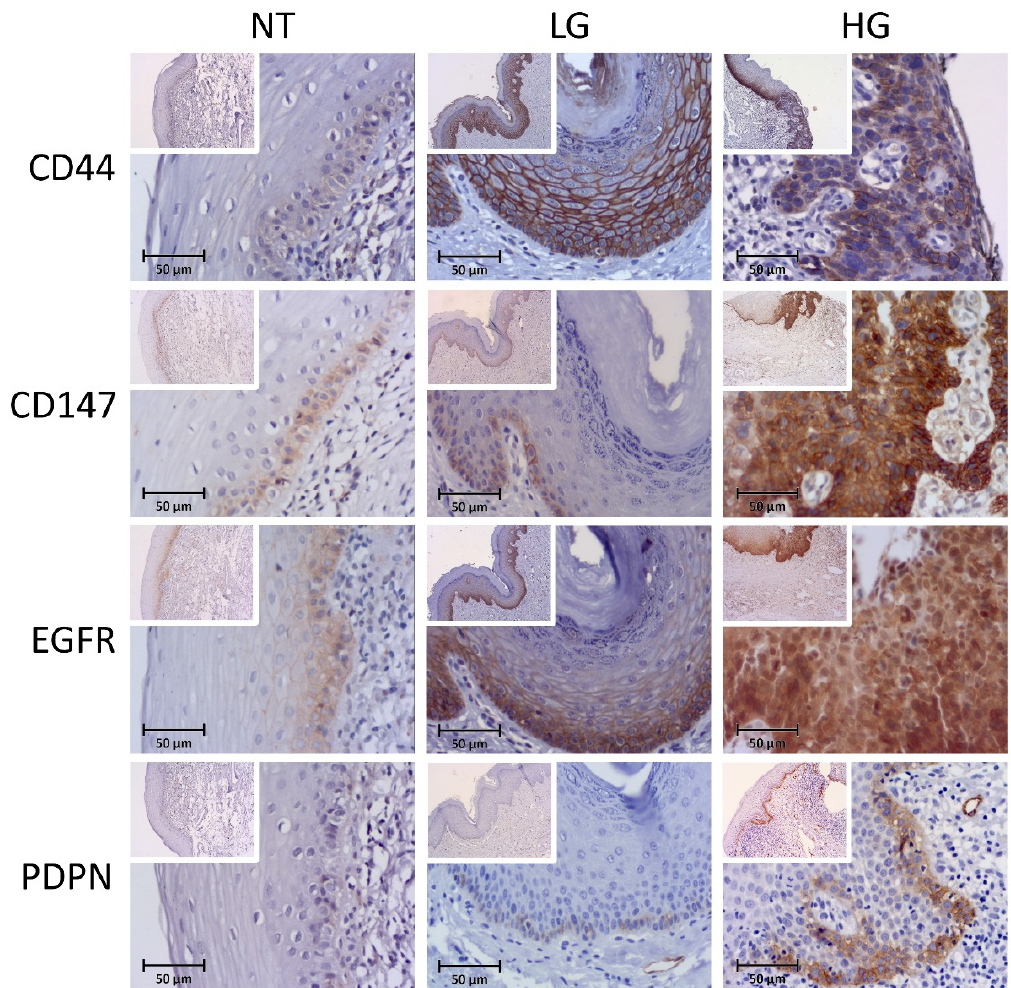
Figure 1. Immunohistochemical staining of the CD44v6, CD147, EGFR, podoplanin (PDPN)